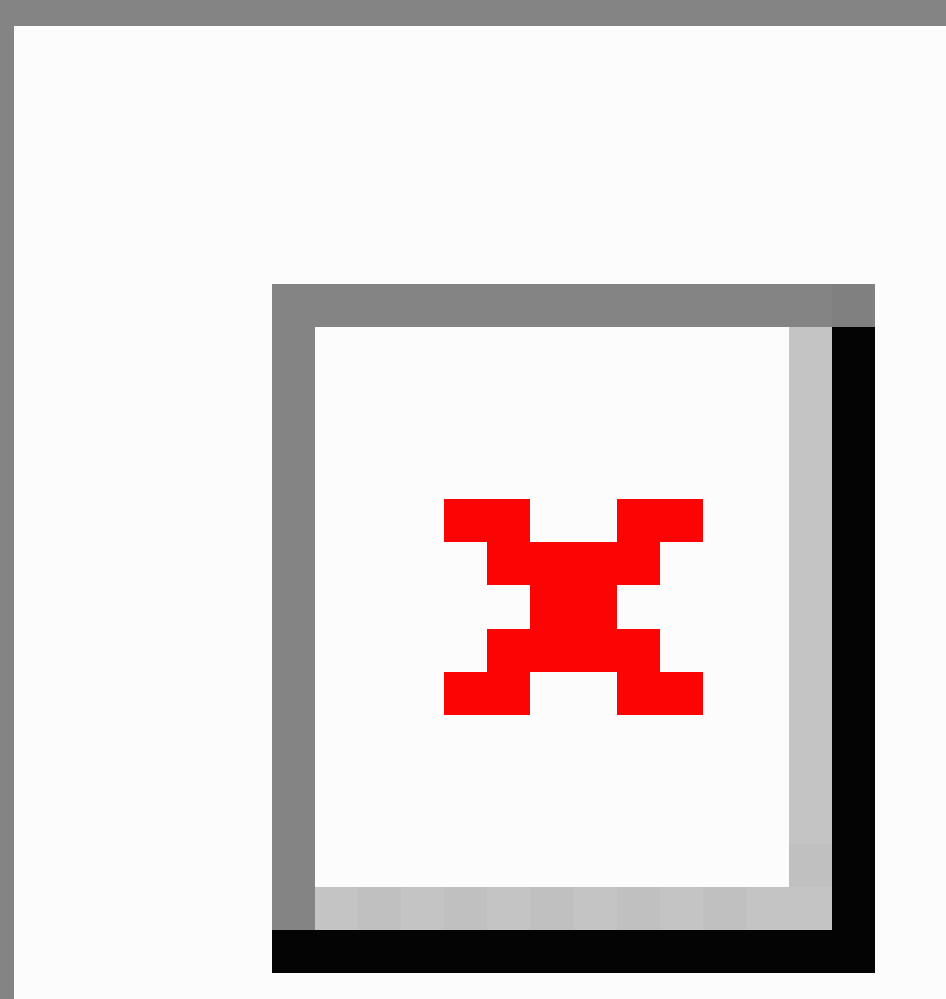
Figure 3. Some of the community-based venues promoted through our social media